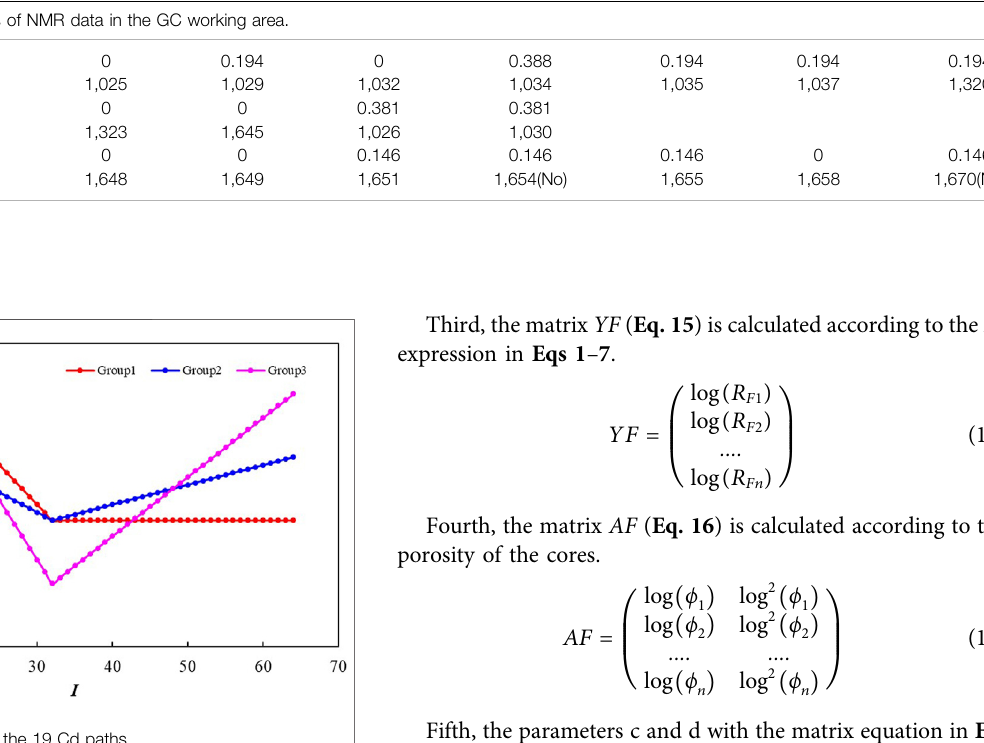
TABLE 1 | Cd path classi fi cations of NMR data in the GC working area. Group-1